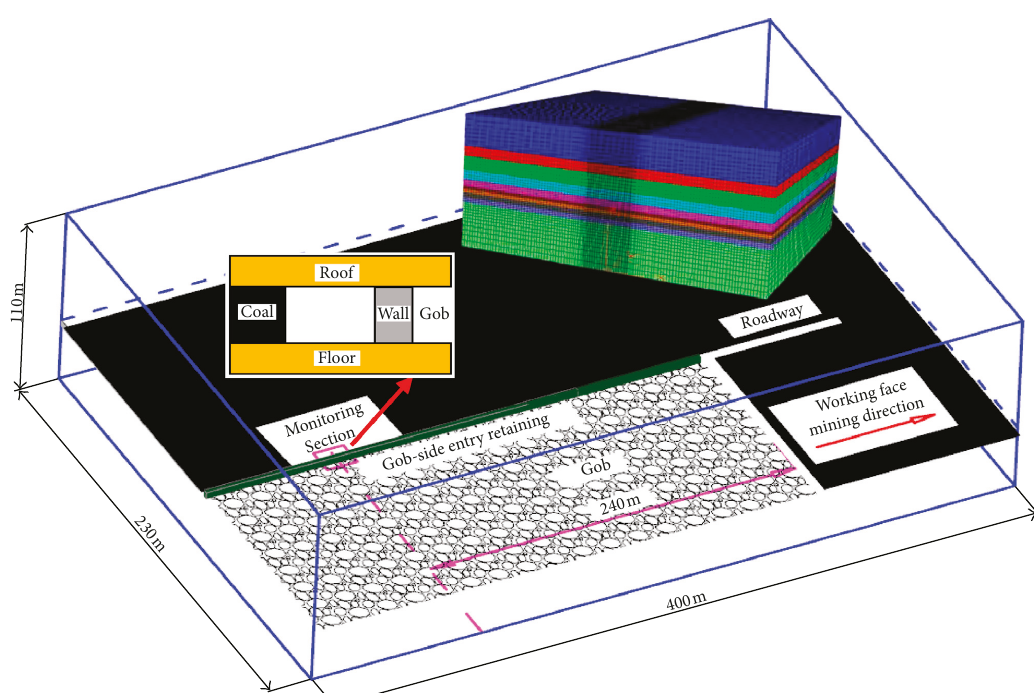
Figure 2: Gob-side entry retaining physical model and numerical calculation model.